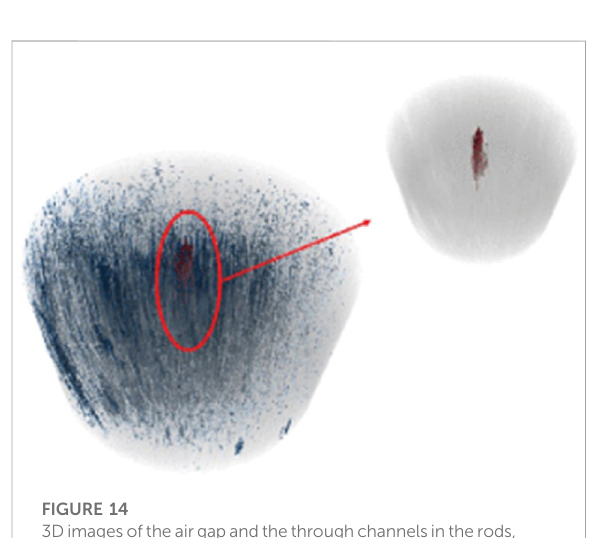
FIGURE 14 3Dimagesoftheairgapandthethroughchannelsintherods, obtained by the X-ray micro-CT method (Huang et